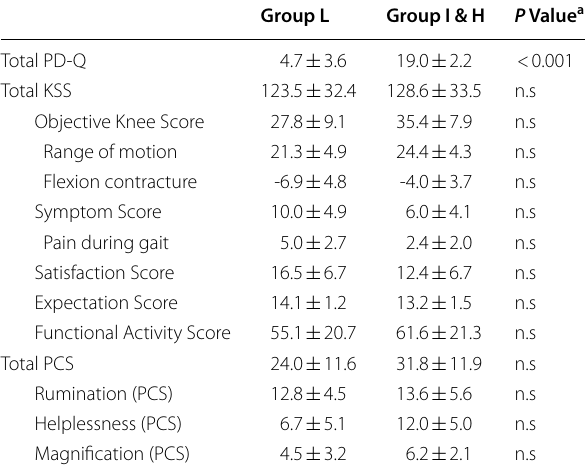
Table 2 Clinical score and patient-reported assessment in each group based on PD-Q (mean